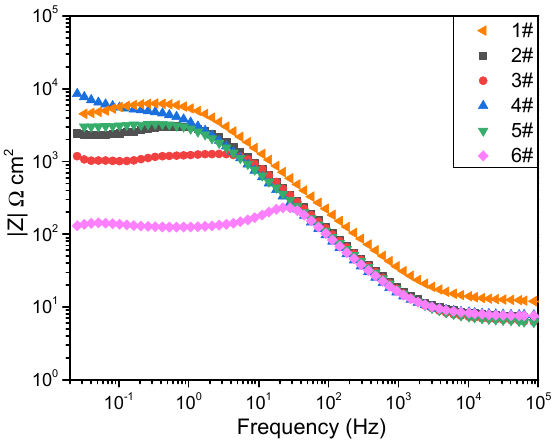
Figure 4. The Bode diagram of six alloys.